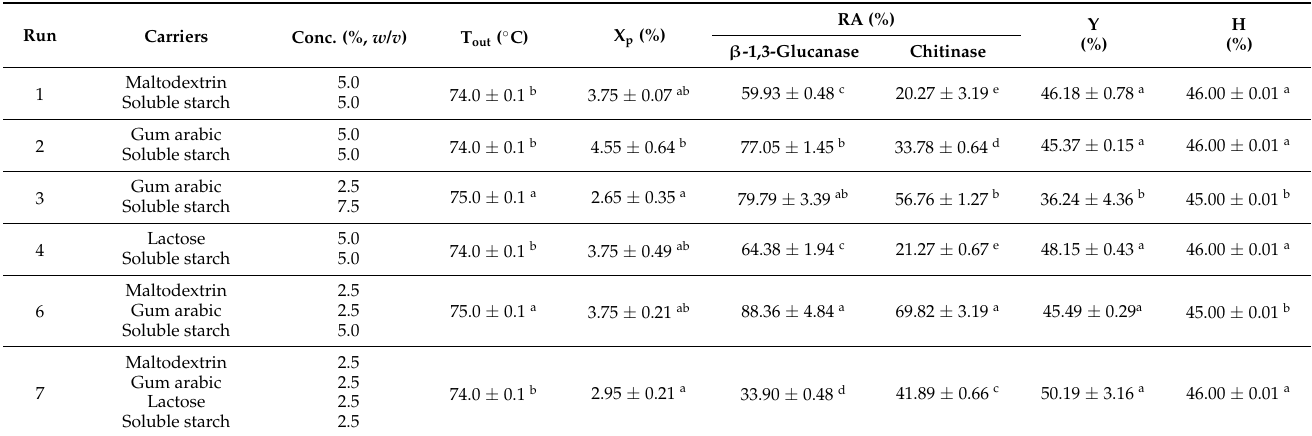
Table 3. Effect of different carrier combinations and concentrations in the spray drying of enzyme extract.